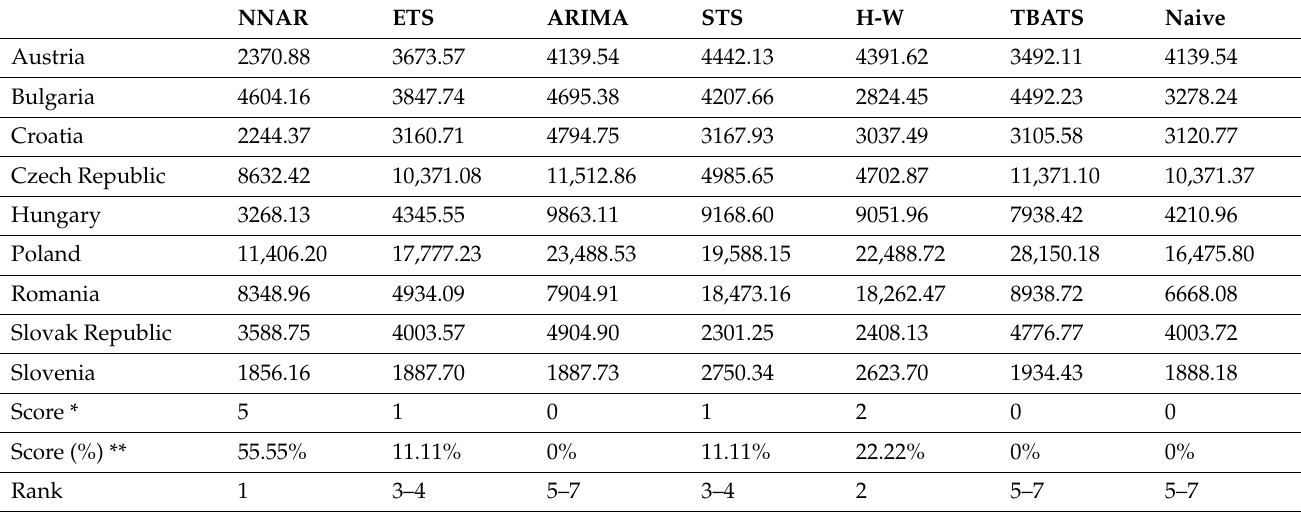
Table 2. Prediction accuracy (RMSE for out-of-sample forecasting, forecasting horizon h = 8). NNAR ETS ARIMA STS H-W TBATS